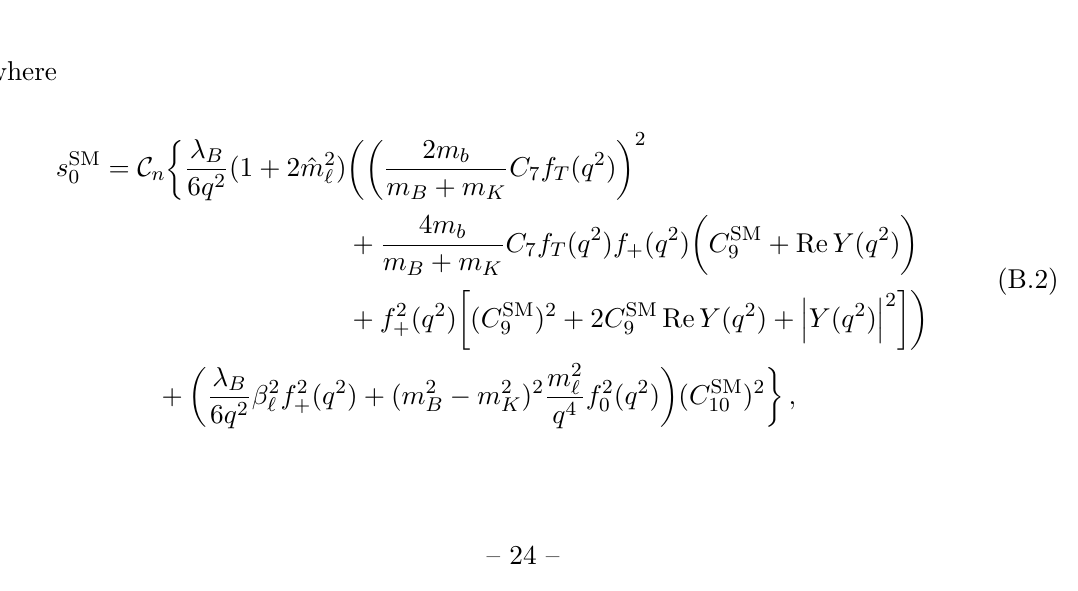
Table 1 . Numerical values of the coefficients in appendix A. q 2 ranges are given in units of GeV 2 . All results are specific to B ± → K ± µ + µ −